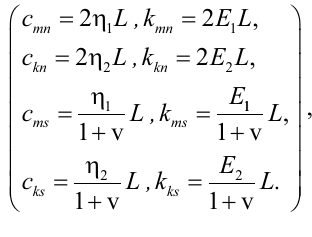
The normal and tangential models of contacts between asphalt mortar sphere-particles are shown in Figure